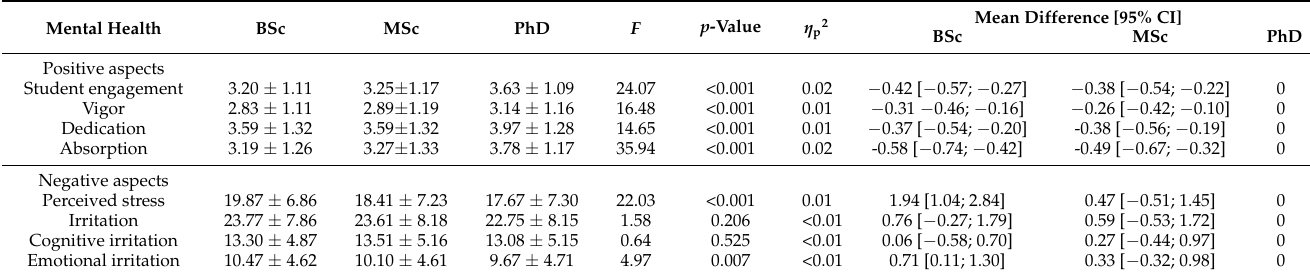
Table 4. Student mental health by academic level for continuous